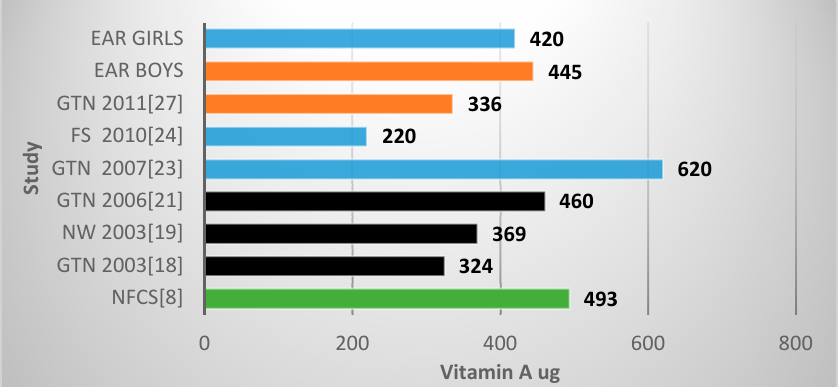
Figure 4. Mean vitamin A intake in studies on schoolchildren in South Africa between 2000 and 2015 with the blue bars representing two studies which included fortification values. EAR: estimated average intake; GTN: Gauteng; FS: Free State; NW: North West; NFCS: National Food Consumption Survey.